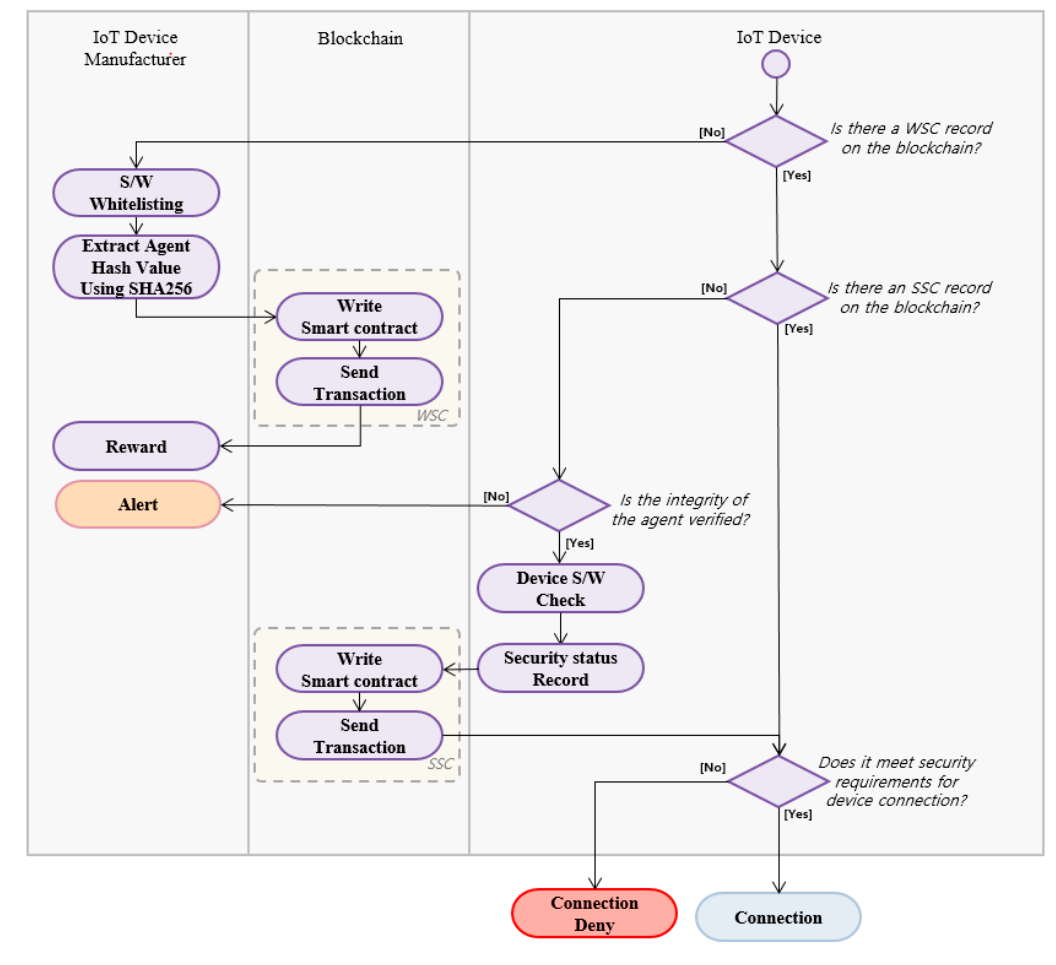
Figure 2. Flowchart for the proposed secure IoT extension.